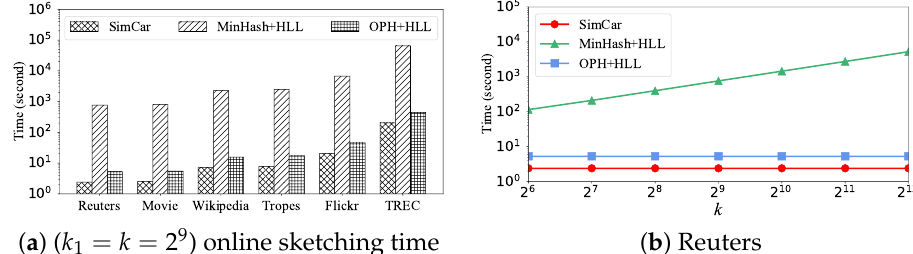
Figure 2. Online sketching time of our framework, SimCar, in comparison with MinHash and HLL and OPH and HLL. ( a ) Sketching time on different datasets with k 1 = k = 2 9 . ( b ) Sketching time on dataset Reuters with different k